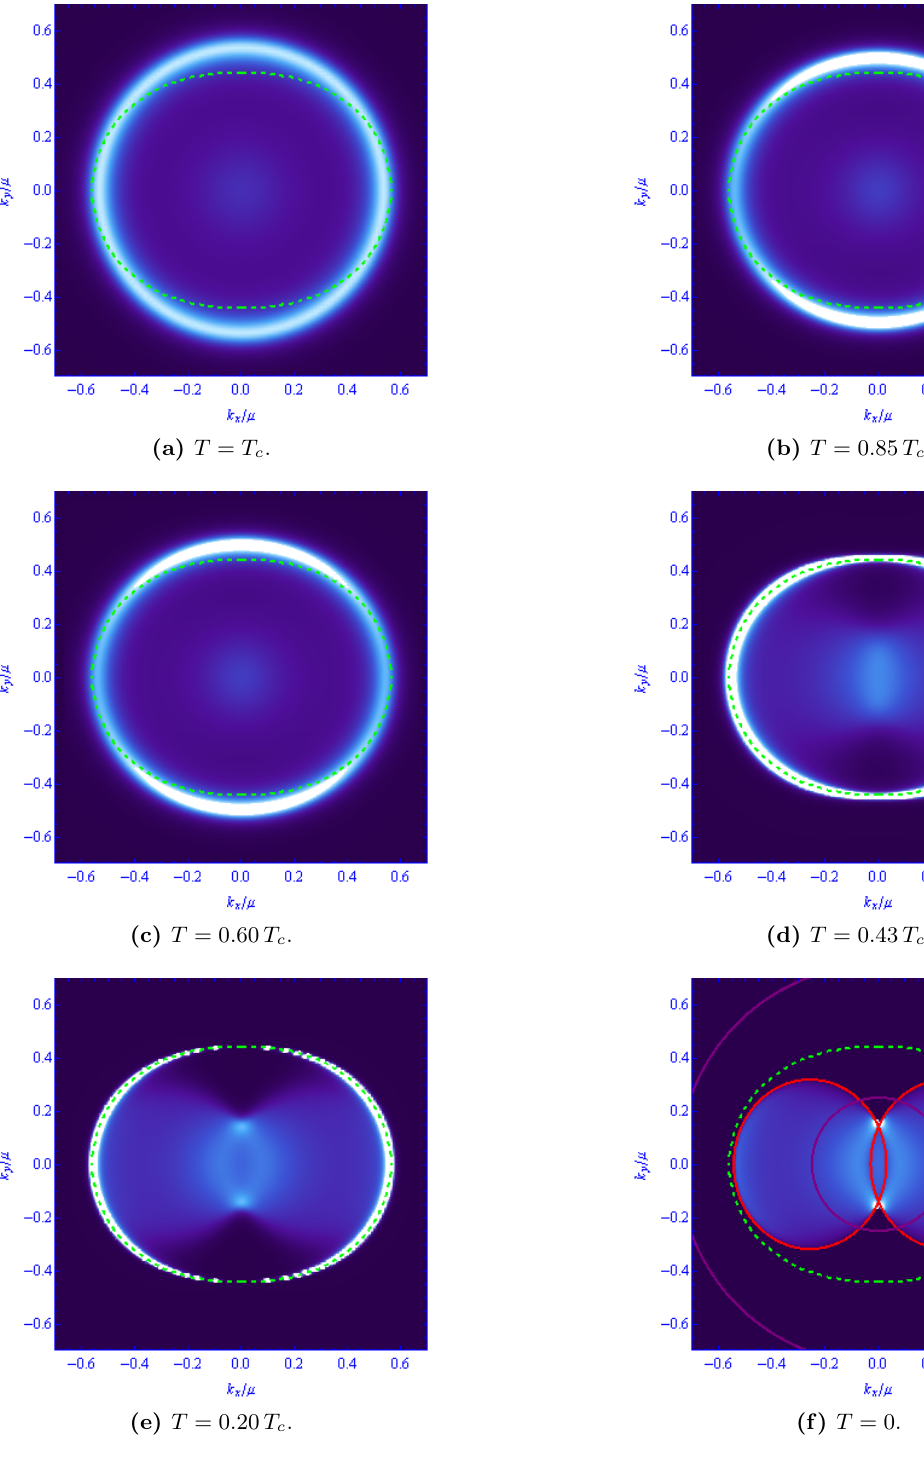
Figure 5. The spectral function for di(cid:11)erent temperatures and (cid:12)xed (cid:21) = 0 : 40 < (cid:21) c , ! = 0 : 25 (cid:22) . It is observed the presence of spherical symmetry at T = T c . The dashed lines indicates the locus of the normal modes. The purple and red circles represent the UV and IR Dirac cones respectively.